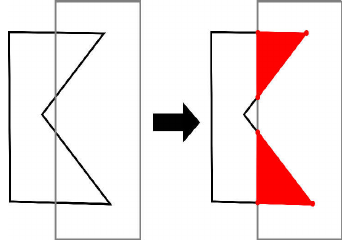
Figure 16: Partially embedded polygons intersection type (overlapping intersection in red)